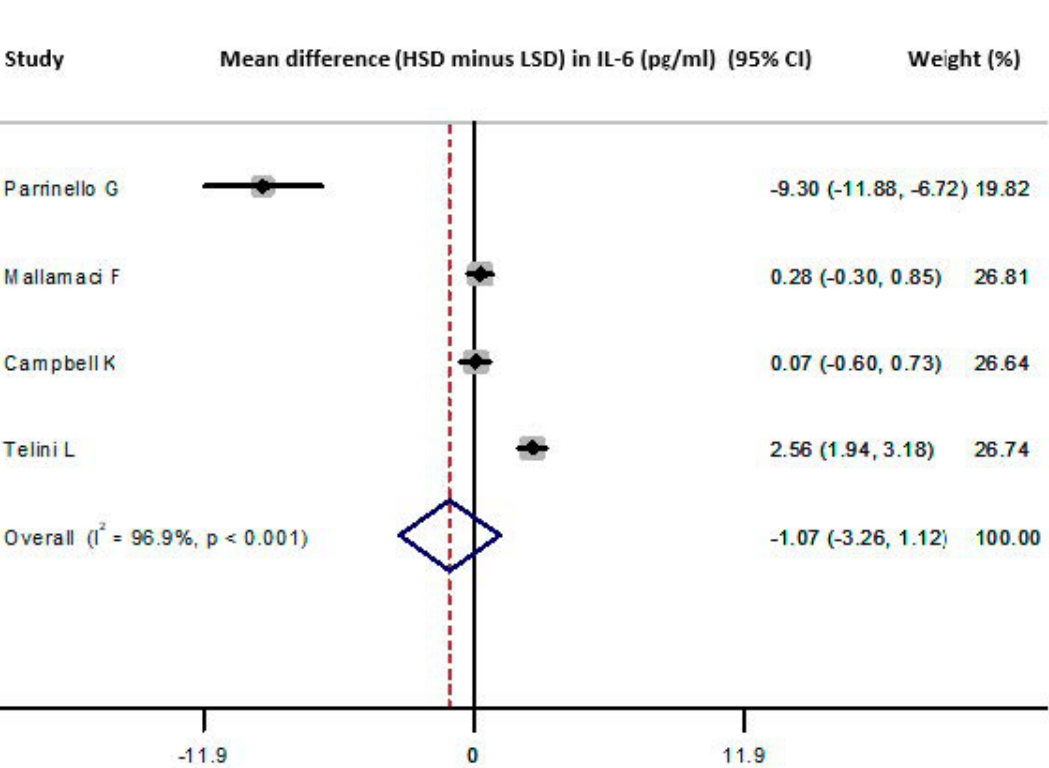
Figure 4. Forest plot of the mean difference in TNF-a levels for high sodium dose (HSD) versus low sodium dose (LSD) as defined per study [27,37,40,42].